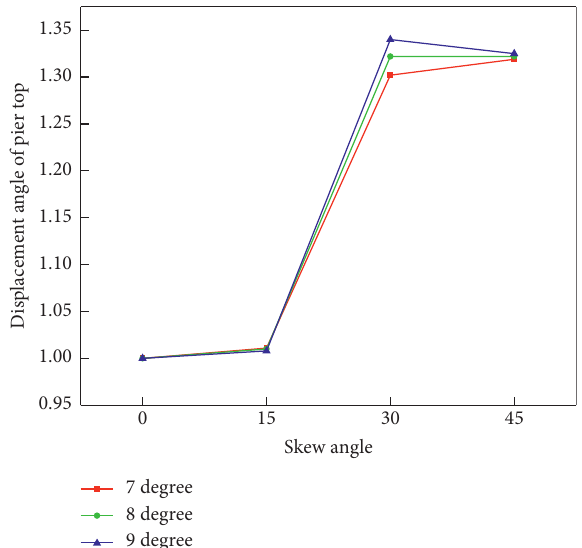
Figure 4: Influence of skew angle on displacement angle of bridge pier